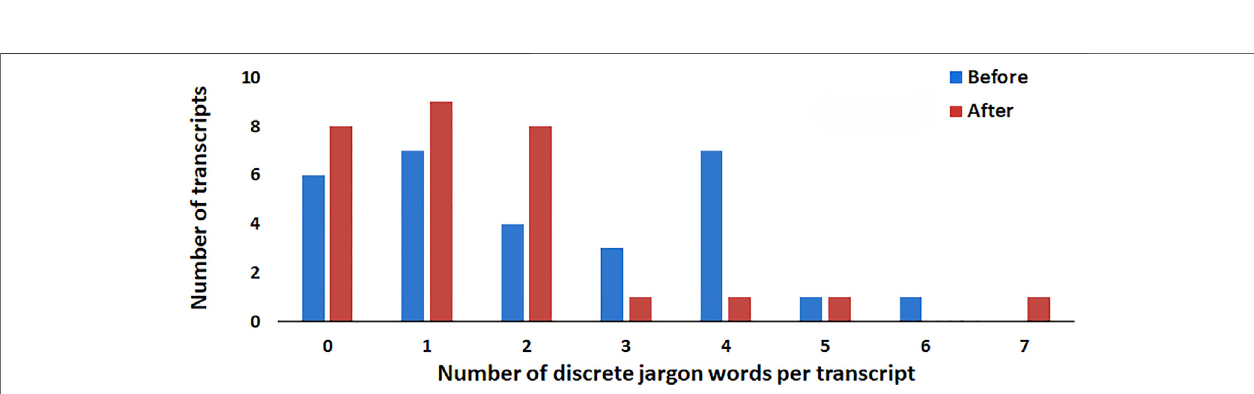
FIGURE 4 | The number of discrete jargon words used, per transcript, before (blue) and after (red) science communication training. After training, the number of transcripts in which trainees used two or fewer different jargon words rose, as the number of transcripts in which trainees used many different jargon words fell.